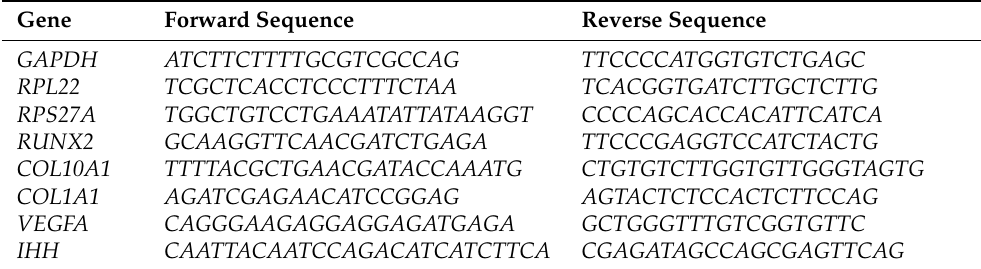
Table 2. Primer sequences as used in this